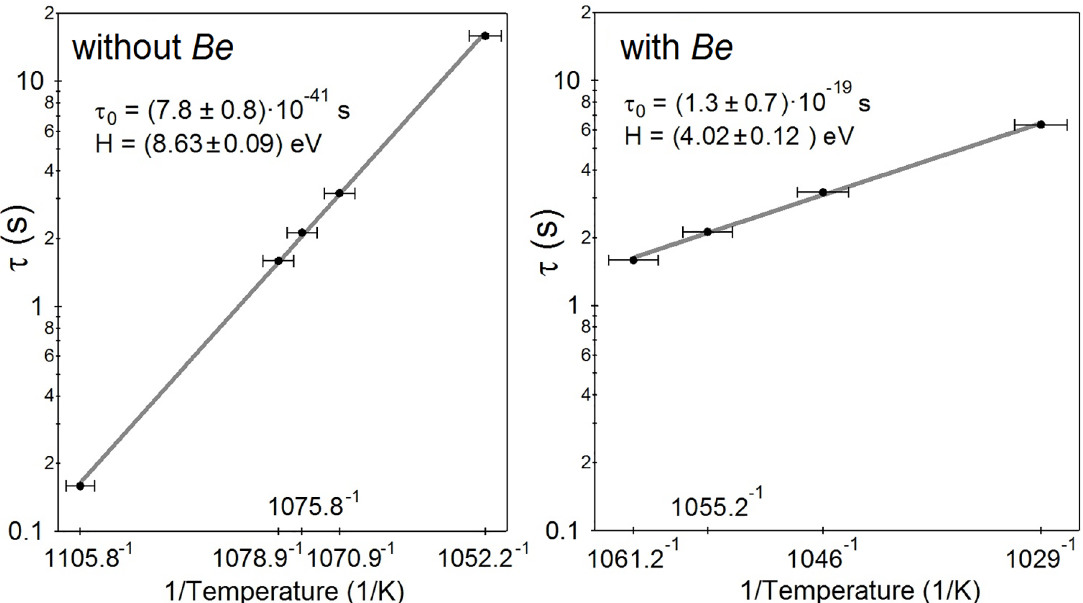
Figure 4. Arrhenius plot obtained for peak P2 provides an apparent activation energy due to a limit relaxation time τ